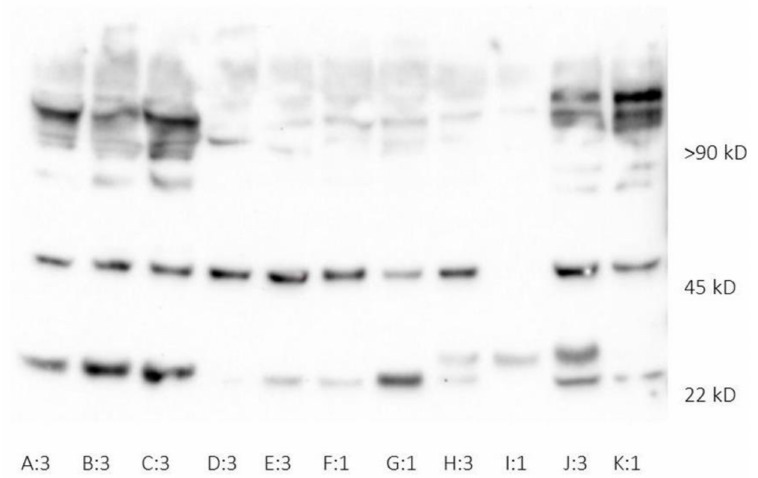
Figure 1. Western blot of plasma samples during the first week of ICU treatment. Monomeric (22